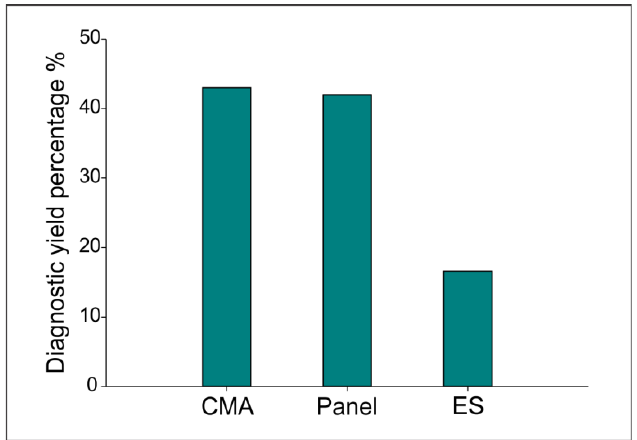
CMA, gene panel and ES diagnostic yield percentages in our